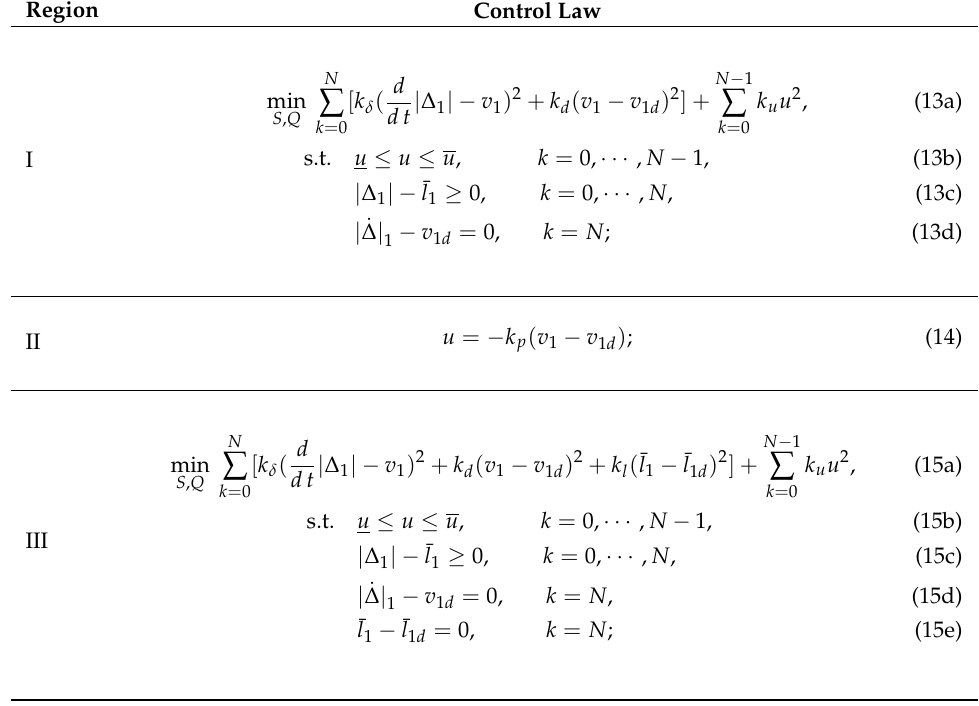
Table 3. Summary of the control algorithm for different